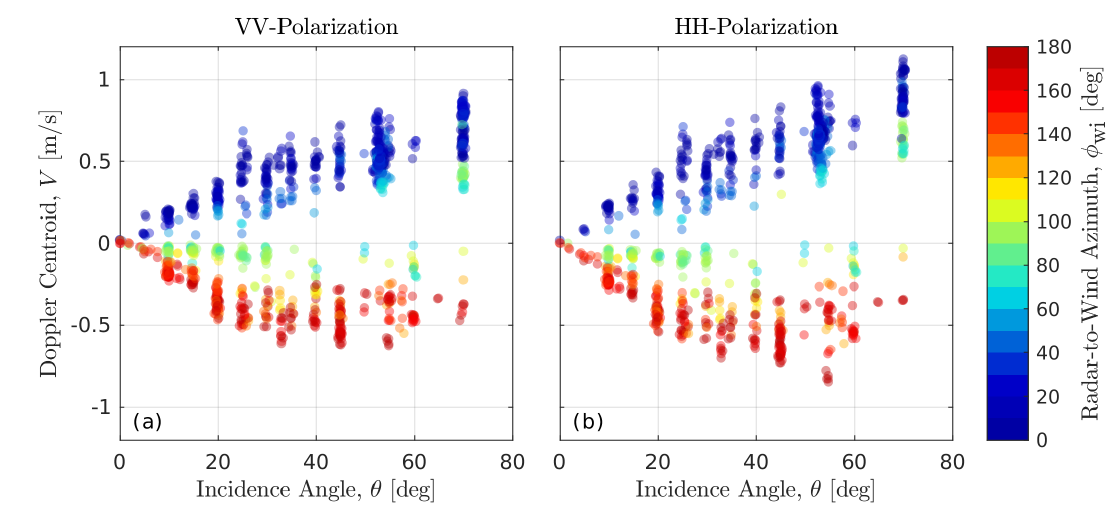
Figure 3. Doppler centroids versus incidence angle, θ , for dual co-polarized ( a ) vertical transmit–receive polarization (VV) polarization and ( b ) horizontal transmit–receive polarization (HH) polarization. Color indicates radar-to-wind azimuth. Only co-aligned winds and waves, | φ wi − φ wa | < 25 ◦ , are shown. Gaussian noise is added to the nominal θ for better visibility, STD ( θ noise ) = 0.25 ◦ .